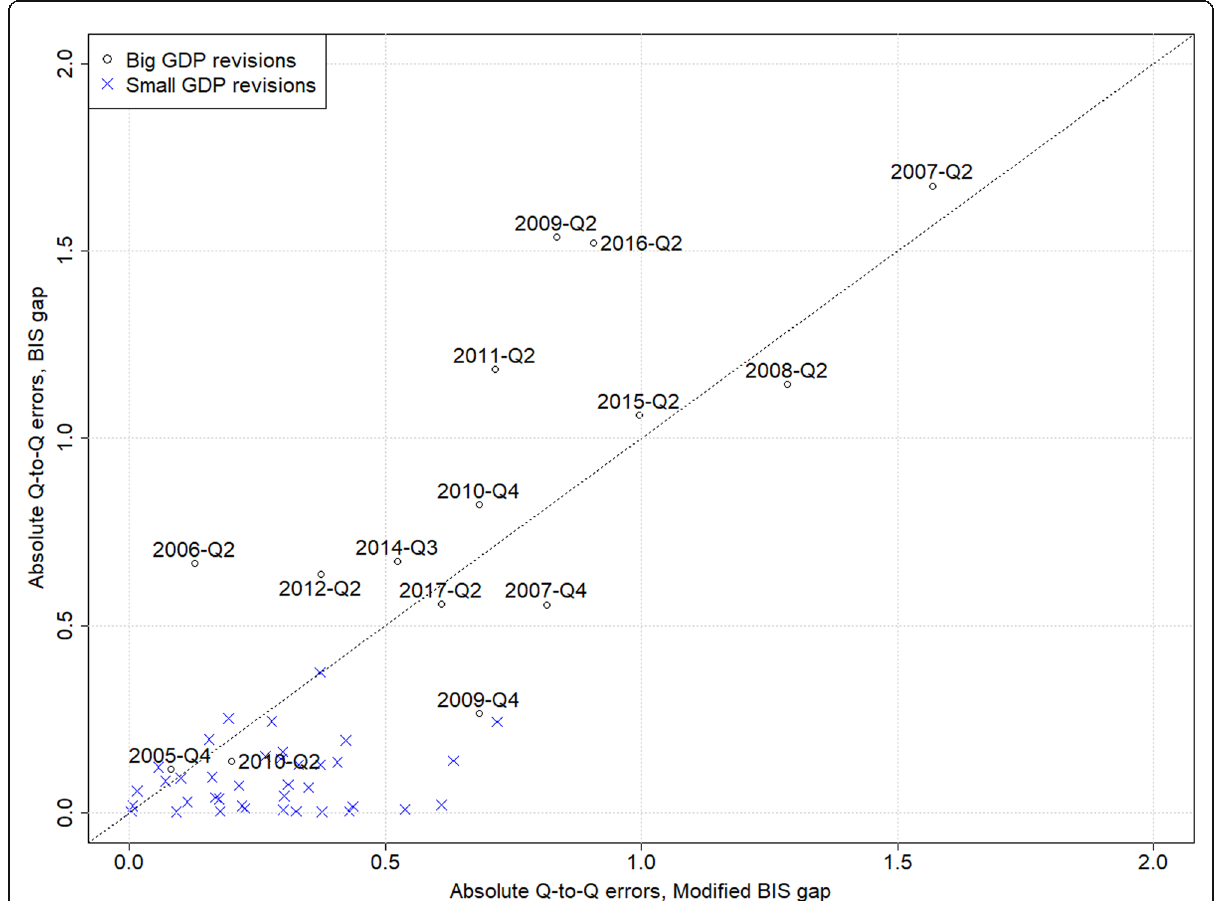
Fig. 7 Absolute quarterly combined errors. BIS gap ( y -axis) vs. modified BIS gap ( x -axis) in percentage points. Note: A GDP revision is classified as “ big ” if its relative difference, in absolute value, to the previous quarter ’ s vintage is greater than 0.66% at least once (see Fig. 3, in which 15 GDP vintages have at least one revision of greater than 0.66% and are denoted by dark red and red rectangles)